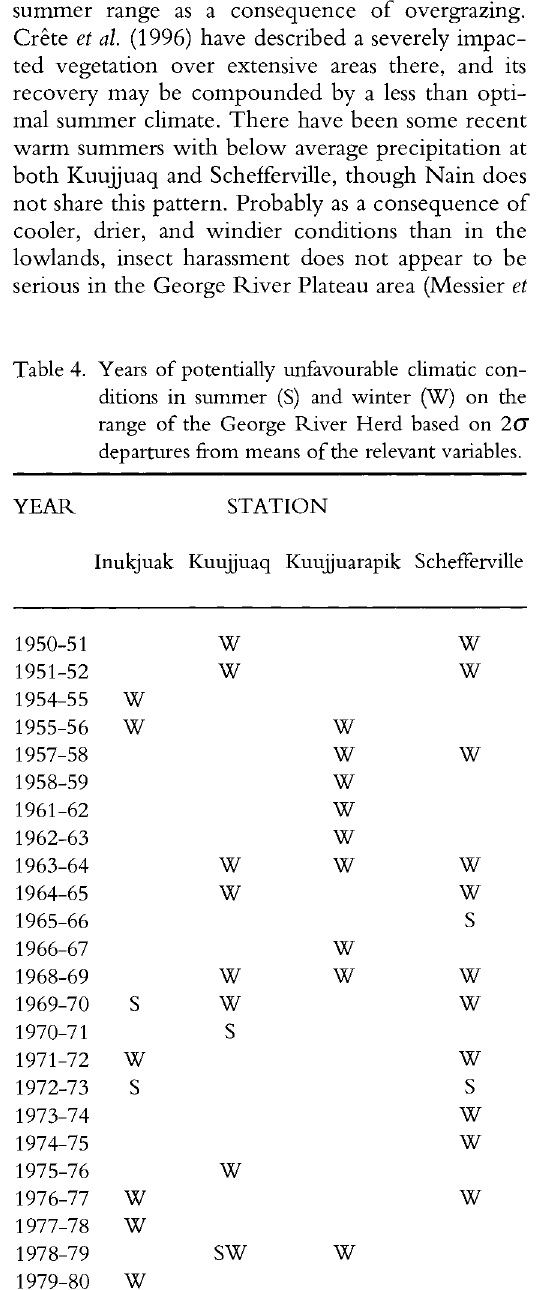
Table 4. Years of potentially unfavourable climatic con ditions in summer (S) and winter (W) on the range of the George River Herd based on 2 (7 departures from means of the relevant